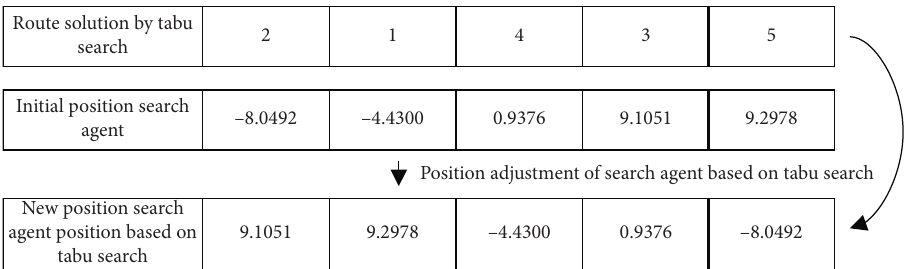
Figure 9: Illustration of tabu search converted solution to the position of search